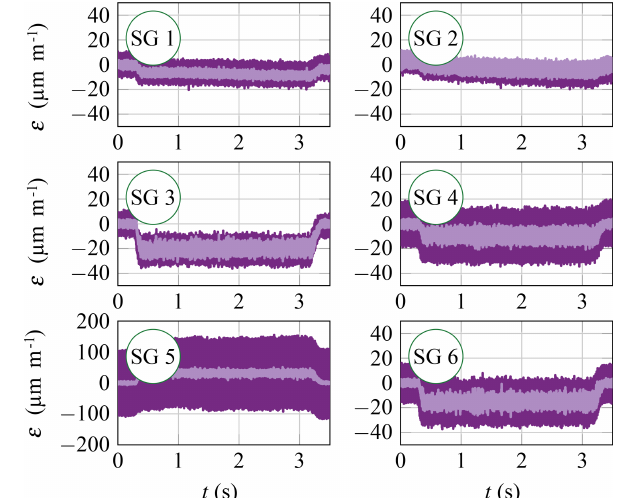
Figure 4. Typical results for measured strain ( ε ) in the sonotrode plotted against time for surface finishing of a sample during pro- cessing with (dark violet) and without (light violet) UVA.